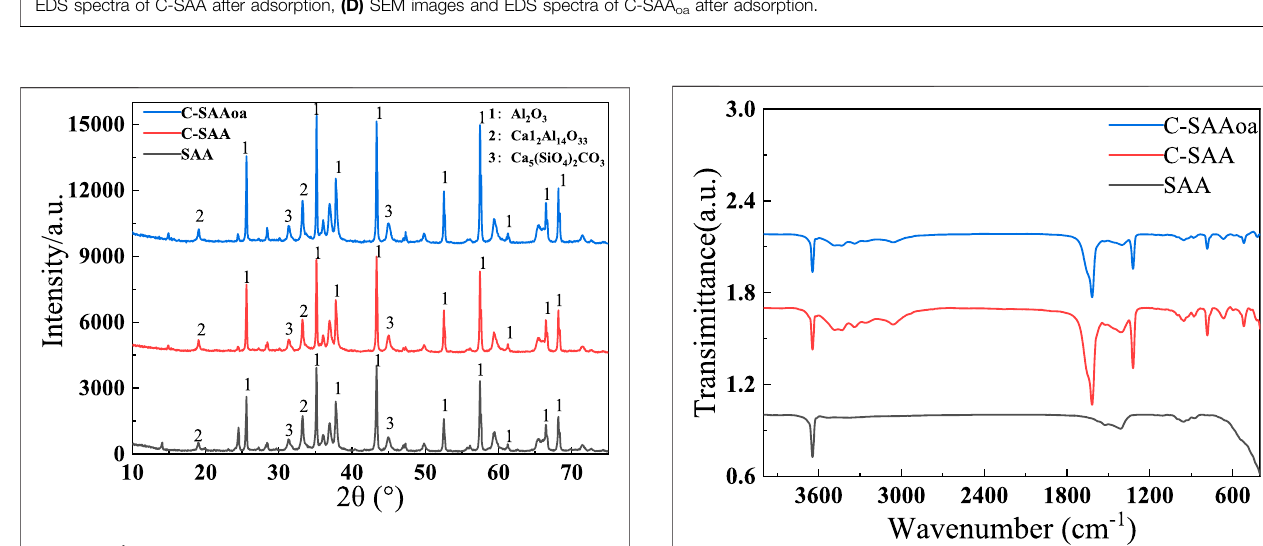
FIGURE 4 | The XRD spectra of SAA 、 C-SAA andC- SAA oa .